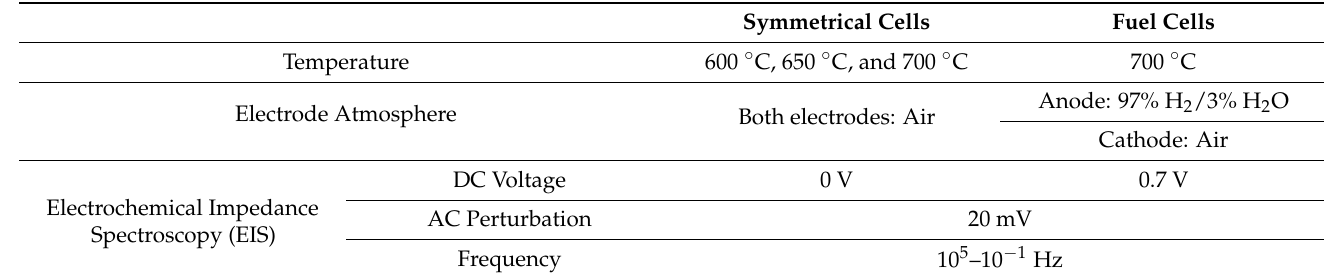
Table 1. Summary of test conditions for symmetrical cells and fuel cells. Temperature